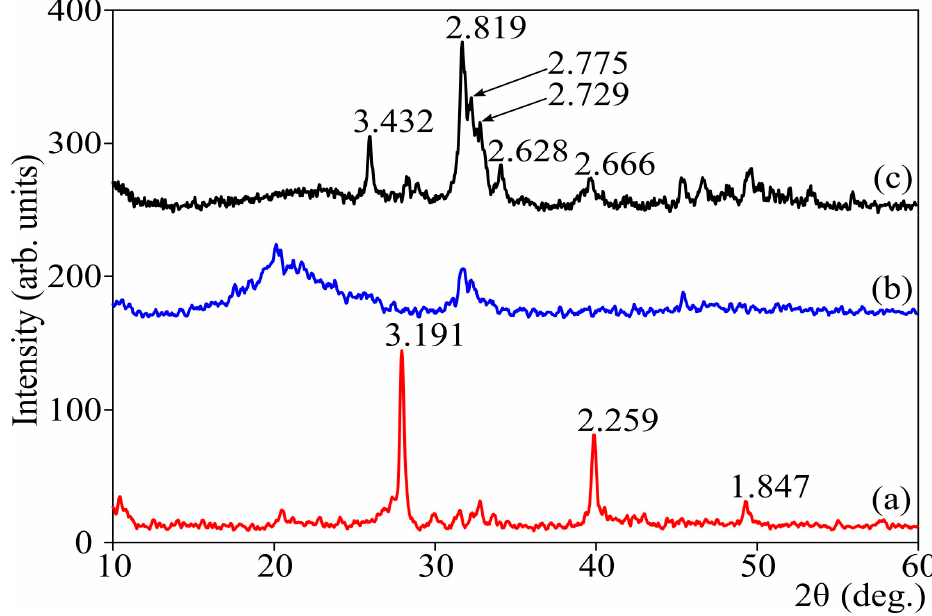
Figure 6. XRD patterns of ( a ) chitosan/phosphate film dried at 100 °C; ( b ) composite produced from chitosan/phosphate film in 0.1 M NaOH during 5 days at 25 °C; ( c ) composite produced from chitosan/phosphate film in 0.1 M NaOH during 12 h at 100 °C. XRD pattern ( c ) corresponds to HA.